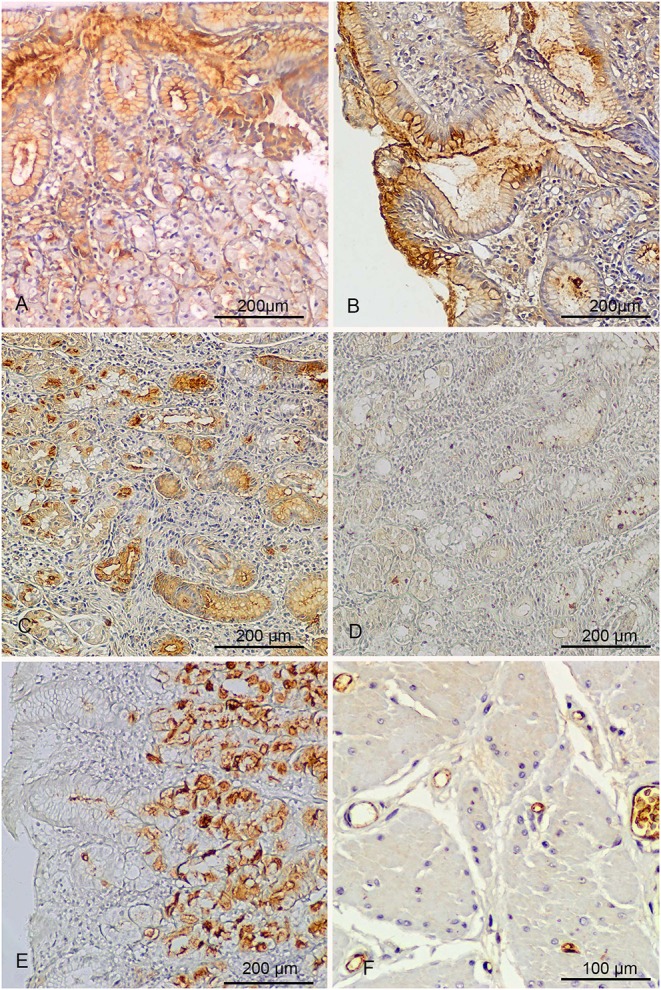
Immunohistochemical analysis. (A) The serum of a patient with H. pylori gastritis and previous history of myocardial infarction tested against autologous gastric biopsy for the presence of autoantibodies. Positive reaction with gastric mucins at the surface and within the cytoplasm of foveolar epithelium (brown staining). (B) Reactivity similar to that observed in patient of A, obtained with a monoclonal antibody cross-reacting with H type 1 (4D2). (C) The strong autoantibody activity against cytoplasmic mucin of both superficial and glandular gastric epithelium in second patient with H. pylori and previous history of myocardial infarction. Note also the reaction against the canalicular structures of parietal cells (left). (D) Complete neutralization of autoantibodies obtained with pre-absorption of serum with H. Pylori. (E) The reaction of an anti H. pylori monoclonal antibody cross-reacting with LeY (1e52), concentrated in the glandular portion of gastric epithelium. (F) Strong expression of LeY at the surface of red blood cells and endothelium, detected with antibody 1E52.